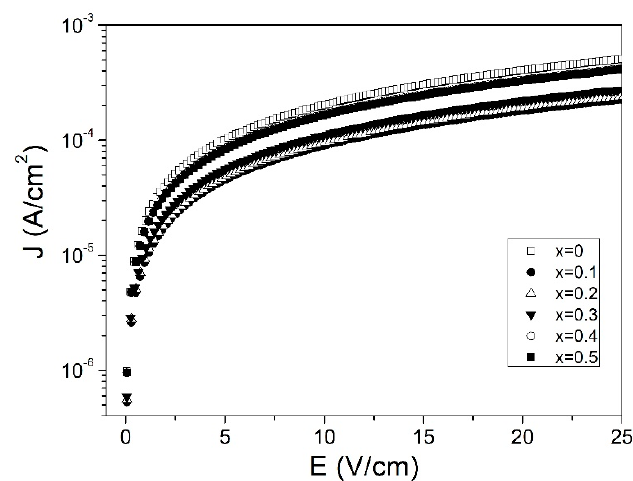
Figure 8. The leakage current density as function of electric field at room temperature of Y 1 − x Bi x FeO 3 with 0 ≤ x ≤ 0.5 samples sintered at 700 °C.